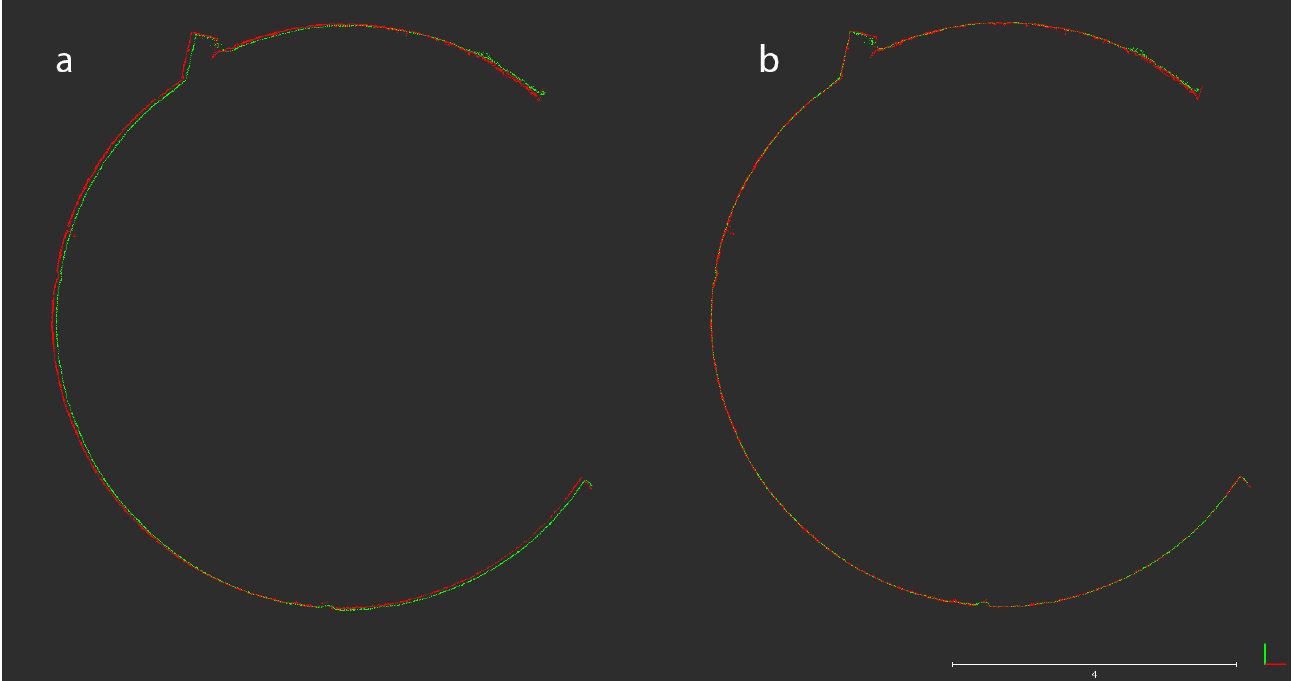
Figure 12. Section on the z axis. ICP analysis on P1 data (green—aligned) and SX10 (red—static reference): ( a ) before the alignment; ( b ) after the alignment. P1 and SX10 point dimension 1